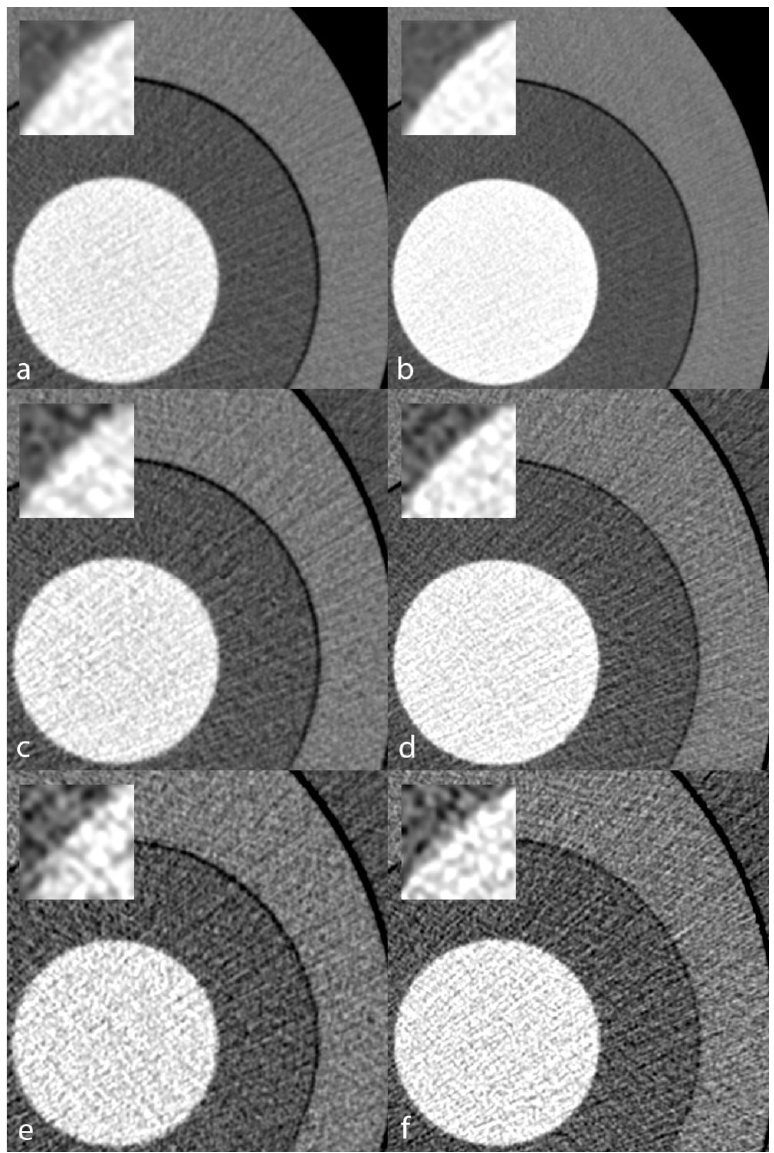
Figure 7. Visual appearance of the TTF phantom inserted in a small ( a , b ), medium ( c , d ), and large ( e , f ) anthropomorphic chest phantom. Conventional reconstructions obtained from acquisitions on the EID ‐ CT ( a , c , e ) and the PCD ‐ CT ( b , d , f ) systems. Zoomed views of the polyethylene/iodinated solution transition better depict the finer noise texture and sharper transition yielded by the PCD ‐